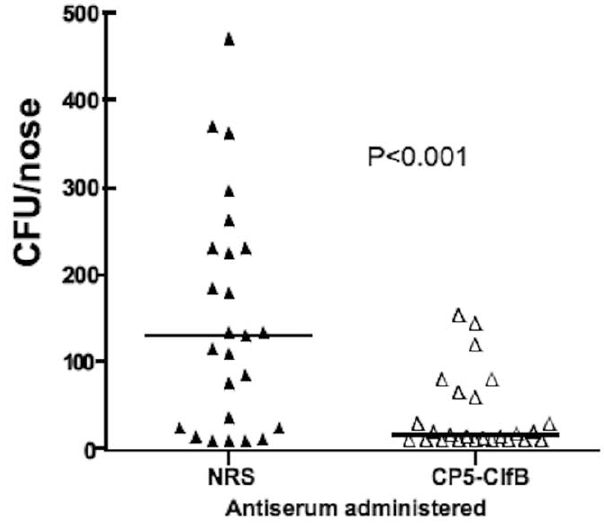
Figure 7. Passive immunization CP5-ClfB antibodies reduced S. aureus Newman nasal colonization. Mice were vaccinated IP with 300 m l of antisera 14 h prior to inoculation with 10 9 CFU. Dots indicate the number of CFU/nose of individual mice, lines the group median, P value by Mann-Whitney U test.